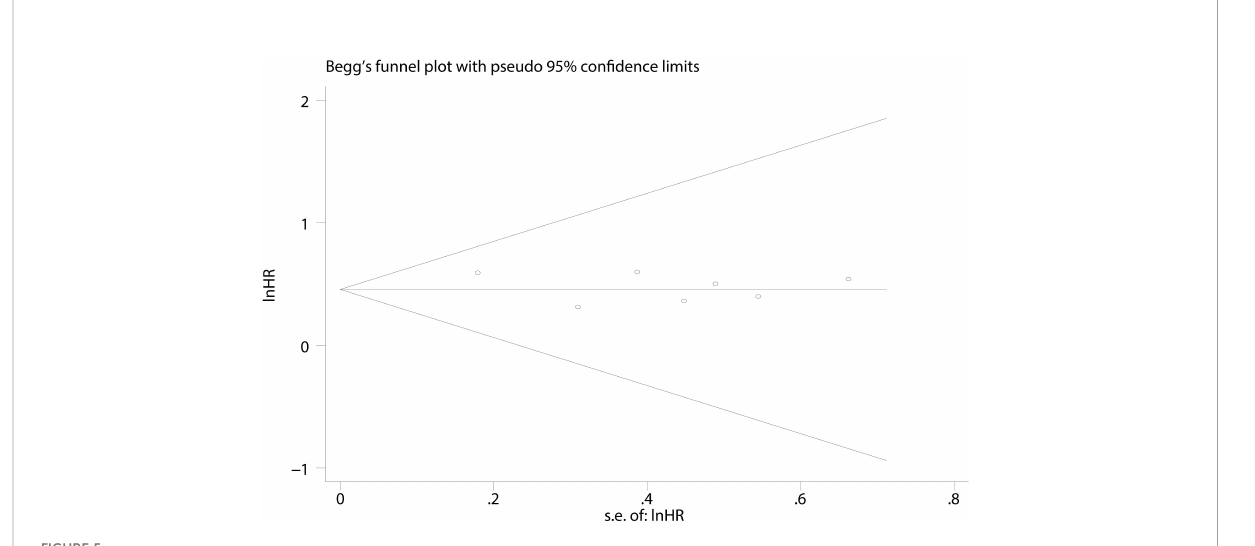
FIGURE 5 Funnel plots based on PD-L1 for cancer-speci fi c